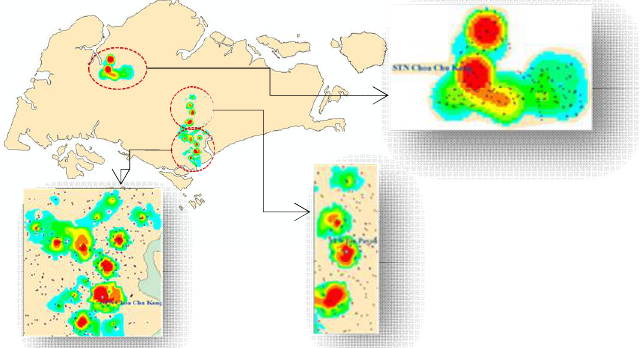
Legend: low (c) Adult: Central Region Figure 5. Spatial mapping of EVC at each station point